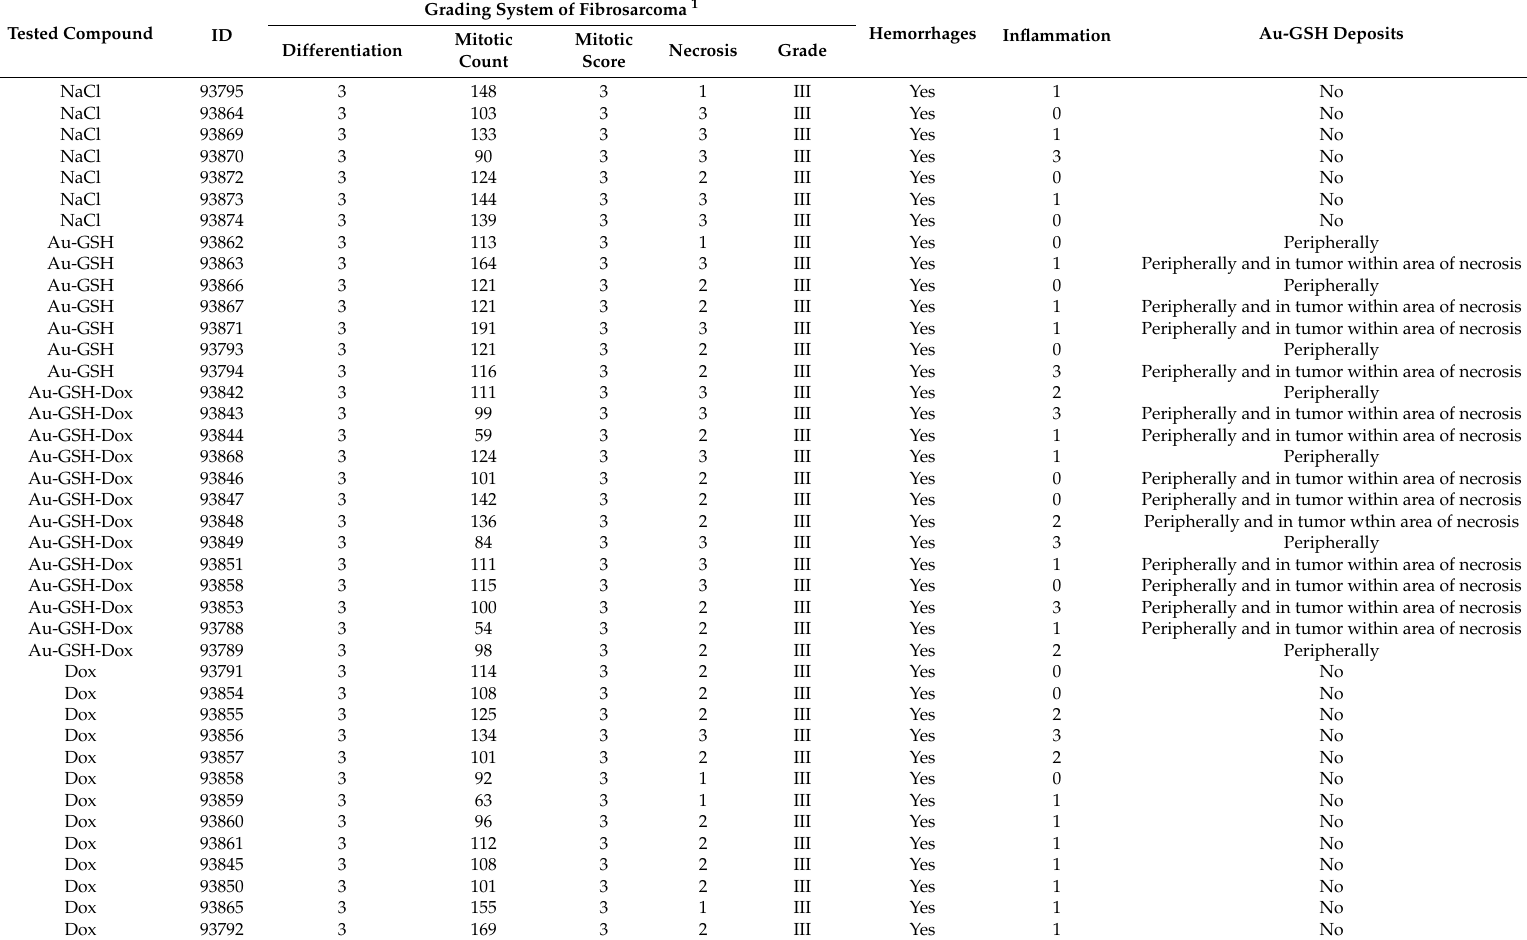
Table 1. Histopathological characterization of feline injection site sarcomas (FISS) growth in a murine model from FFS1 cell